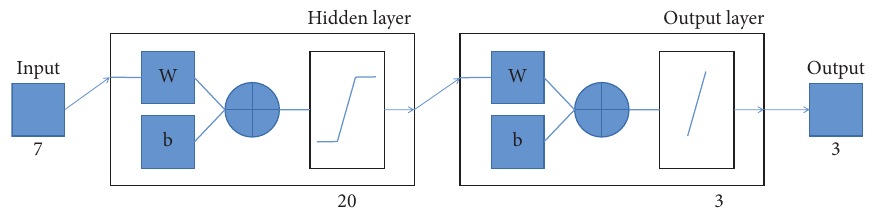
Figure 1: Single hidden layer BP neural network structure. Table 1: Statistics of recognition results of a single weak classifer.